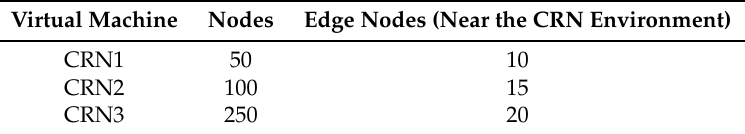
Table 2. Arrangement of NS2 for the diverse CRN milieu.